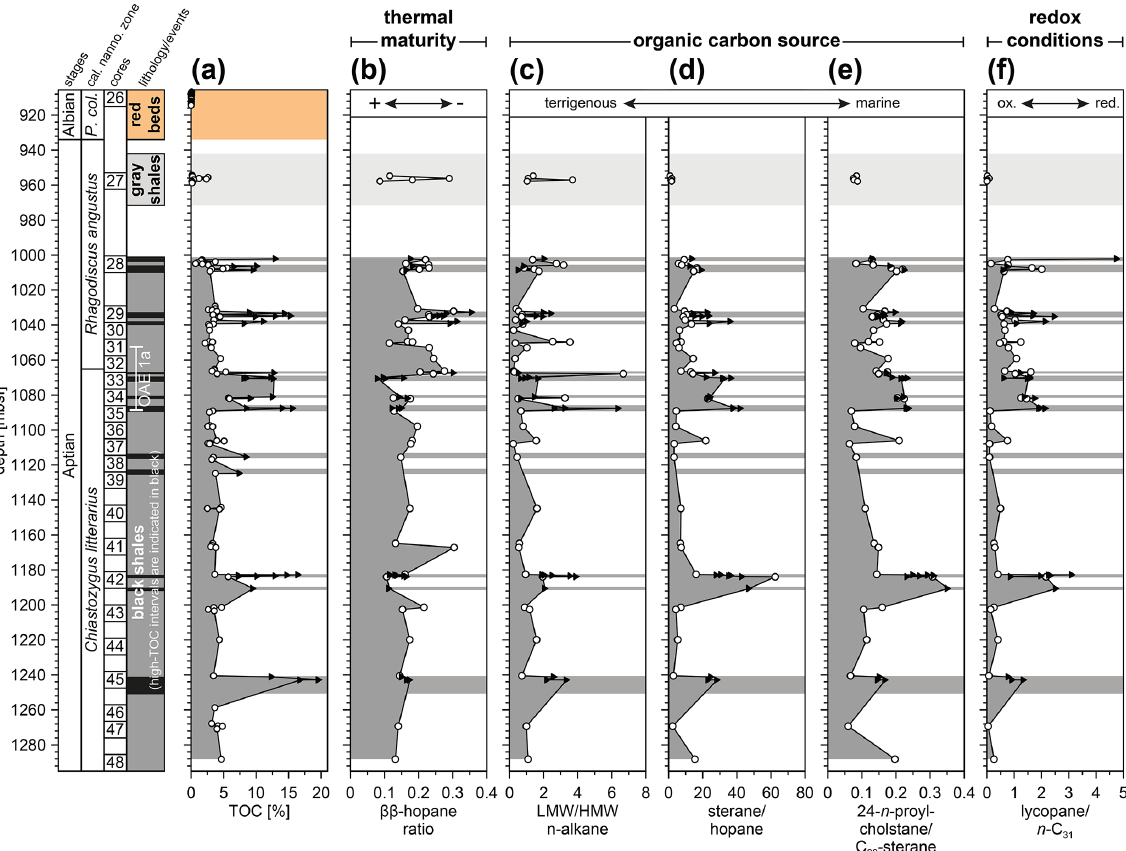
Figure 8. Distribution of selected biomarker parameters used to reconstruct thermal maturity, OC source, and paleo-redox conditions: (a) total organic carbon content (Dummann et al., 2020), (b) ββ / ( ββ + αβ + βα )-C 30 -hopane ratio, (c) low molecular weight/high molecular weight n -alkane ratio, (d) sterane / hopane ratio, (e) 24- n -propylcholestane / C 29 -sterane ratio, and (f) lycopane /n -C 31 ratio. Black triangles with background shading indicate high-TOC black shales ( > 6% TOC). P. col. is short for Prediscosphaera columnata